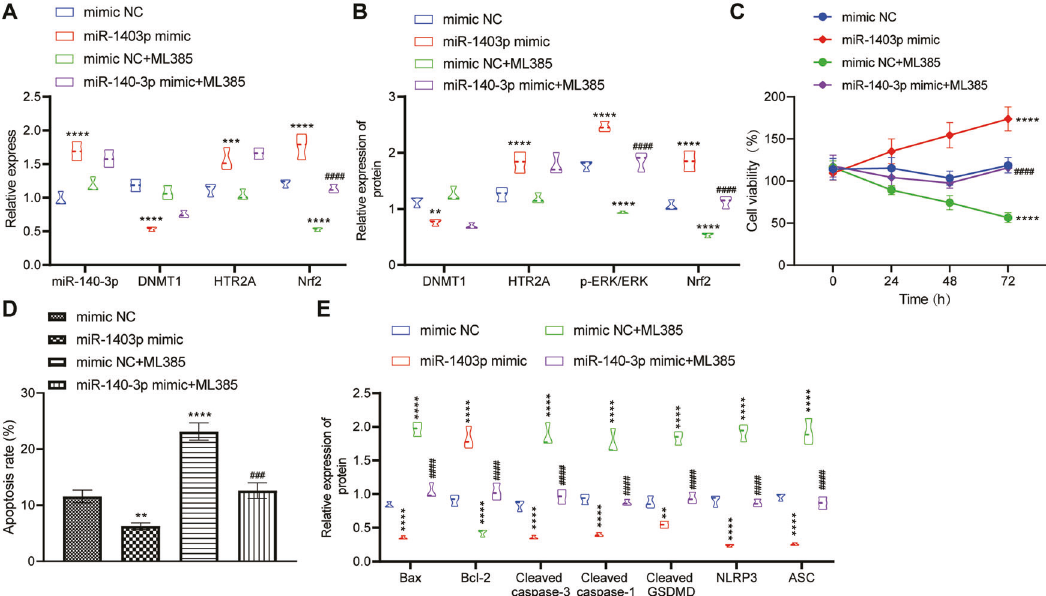
Fig. 6 miR-140-3p manipulates the DNMT1/HTR2A/ERK/Nrf2 axis to facilitate the viability and repress the apoptosis and pyroptosis of rat hippocampal neurons. Hippocampal neurons were transduced with mimic NC, miR-140-3p, mimic NC + ML385, or miR-140-3p + ML385. A The detection of expression of miR-140-3p, DNMT1, HTR2A, and Nrf2 in hippocampal neurons by RT-qPCR. B The detection of protein expression of DNMT1, HTR2A, and Nrf2 and phosphorylated ERK/total ERK protein expression ratio in hippocampal neurons by Western blot analysis. C MTT to detect the cell viability of hippocampal neurons. D The apoptosis of hippocampal neurons determined by fl ow cytometry. E Western blot analysis to detect the protein expression of apoptotic and pyrolytic factors in hippocampal neurons. The experiment was repeated three times. * p < 0.05, ** p < 0.01, and *** p < 0.001 vs. the neurons treated with mimic NC; # p < 0.05, ## p < 0.01, and ### p < 0.001 vs. the neurons treated with miR-140-3p